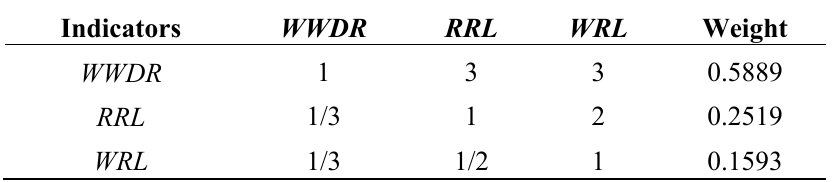
Table A4. The pair-wise comparison matrix for indicators of